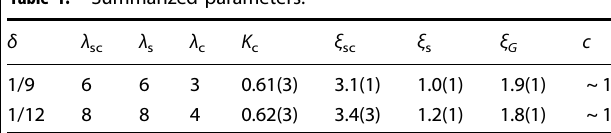
Fig. 3 CDW and Luttinger exponent. a Charge-density pro fi les n ( x ) for three-leg cylinder of length L x = 48 at doping levels δ = 1/9 and δ = 1/ 12 on A and B sub-lattices, respectively. The solid lines denote the fi tting using Eq. (2). b The extracted exponent K c at δ = 1/9 as a function of truncation error ϵ . The dashed line denotes K c extracted from A cdw ( L x ) in ( d ). c Convergence and length dependence of the CDW amplitude A cdw for three-leg cylinder at δ = 1/9 as a function of truncation error ϵ . The solid lines denote fi tting using second-order polynomial function. d Finite-size scaling of A cdw ( L x ) as a function of L x in a double-logarithmic plot at δ = 1/9, where the dashed line denotes the fi tting to a power law A cdw ð L x Þ (cid:4) L (cid:2) K c = 2 . x Table 1. Summarized